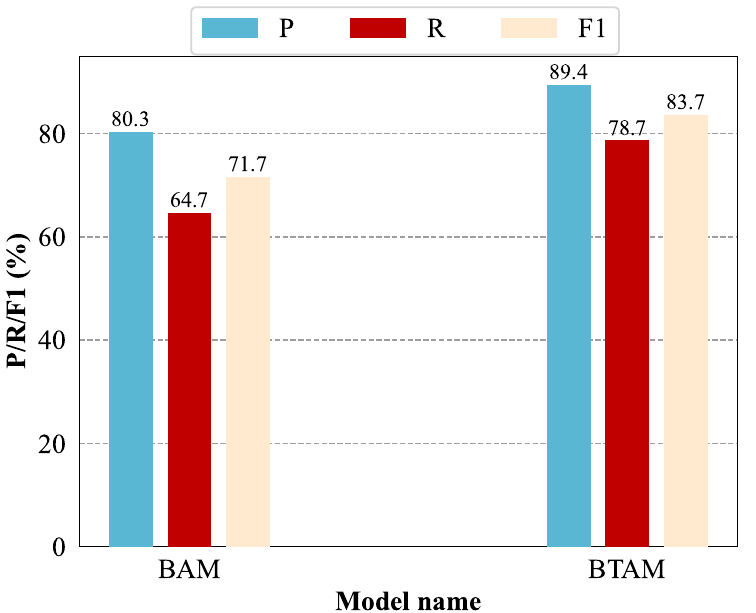
Figure 9. Dependency encoder ablation experimental